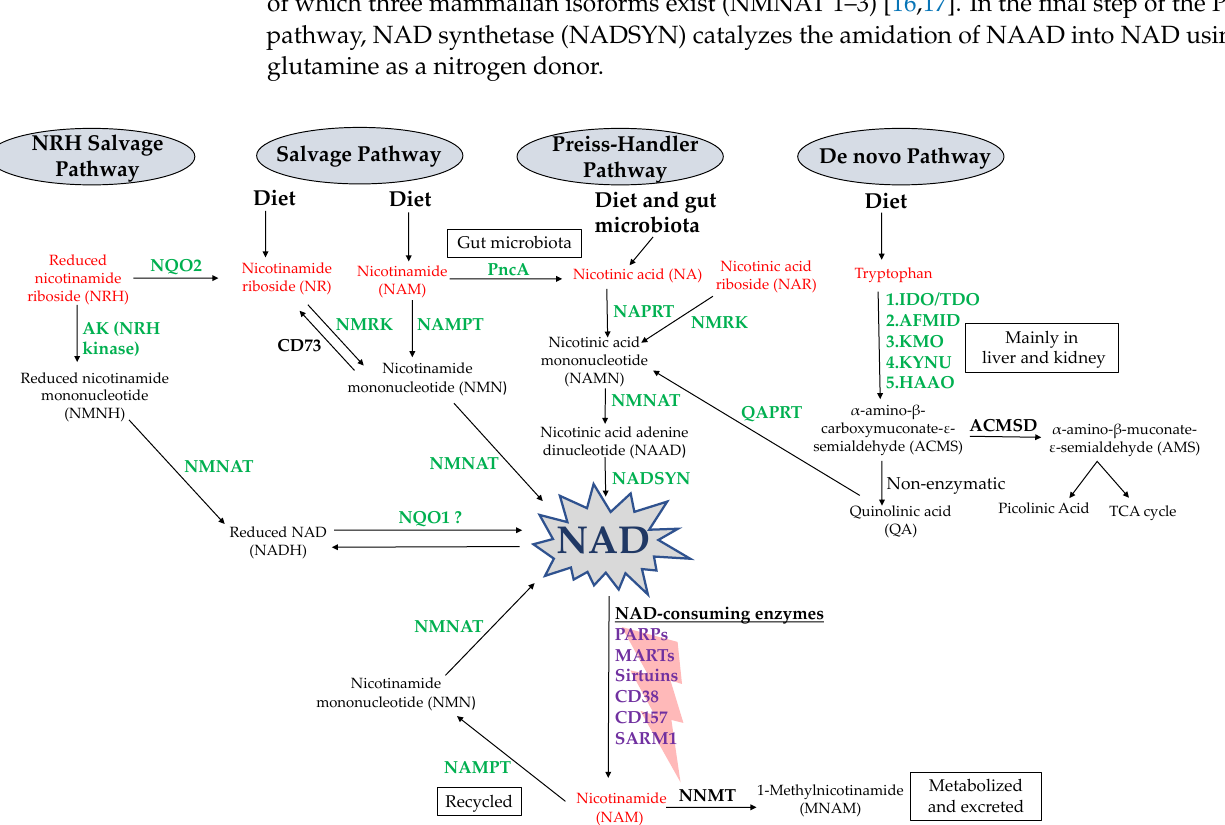
Figure 1. Schematic representation of the NAD biosynthetic pathways. NAD, nicotinamide adenine dinucleotide; NAMPT, nicotinamide phosphoribosyltransferase; NAPRT, nicotinic acid phosphoribosyltransferase; PncA, bacterial nicotinami- dase; NMNAT, nicotinamide mononucleotide adenylyltransferase; NMRK, nicotinamide riboside kinase; NADSYN, NAD synthetase; QAPRT, quinolinic acid phosphoribosyltransferase; IDO, indoleamine-2,3-dioxygenase; TDO, tryptophan- 2,3-dioxygenase; AFMID, arylformamidase; KMO, kynurenine 3-monooxygenase; KYNU, kynureninase; HAAO, 3- hydroxyanthranilate 3,4-dioxygenase; ACMSD, α -amino- β -carboxymuconate- ε -semialdehyde decarboxylase; MARTs, mono(ADP-ribosyl) transferases; PARPs, poly(ADP-ribose) polymerases; SARM 1, sterile alpha and TIR motif-containing 1; NQO1, NAD(P)H:quinone oxidoreductase; NQO2, NRH:quinone oxidoreductase; AK, adenosine kinase; NNMT, nicoti- namide N-methyltransferase; and TCA, tricarboxylic